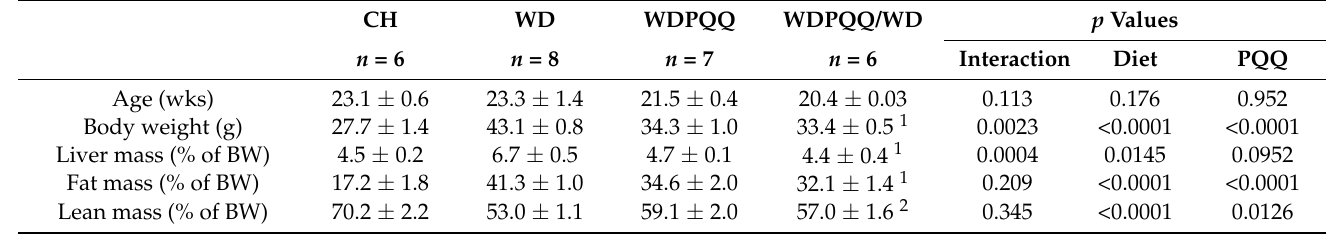
Table 1. Effect of WD and PQQ administration on 20 to 24 wk-old adult